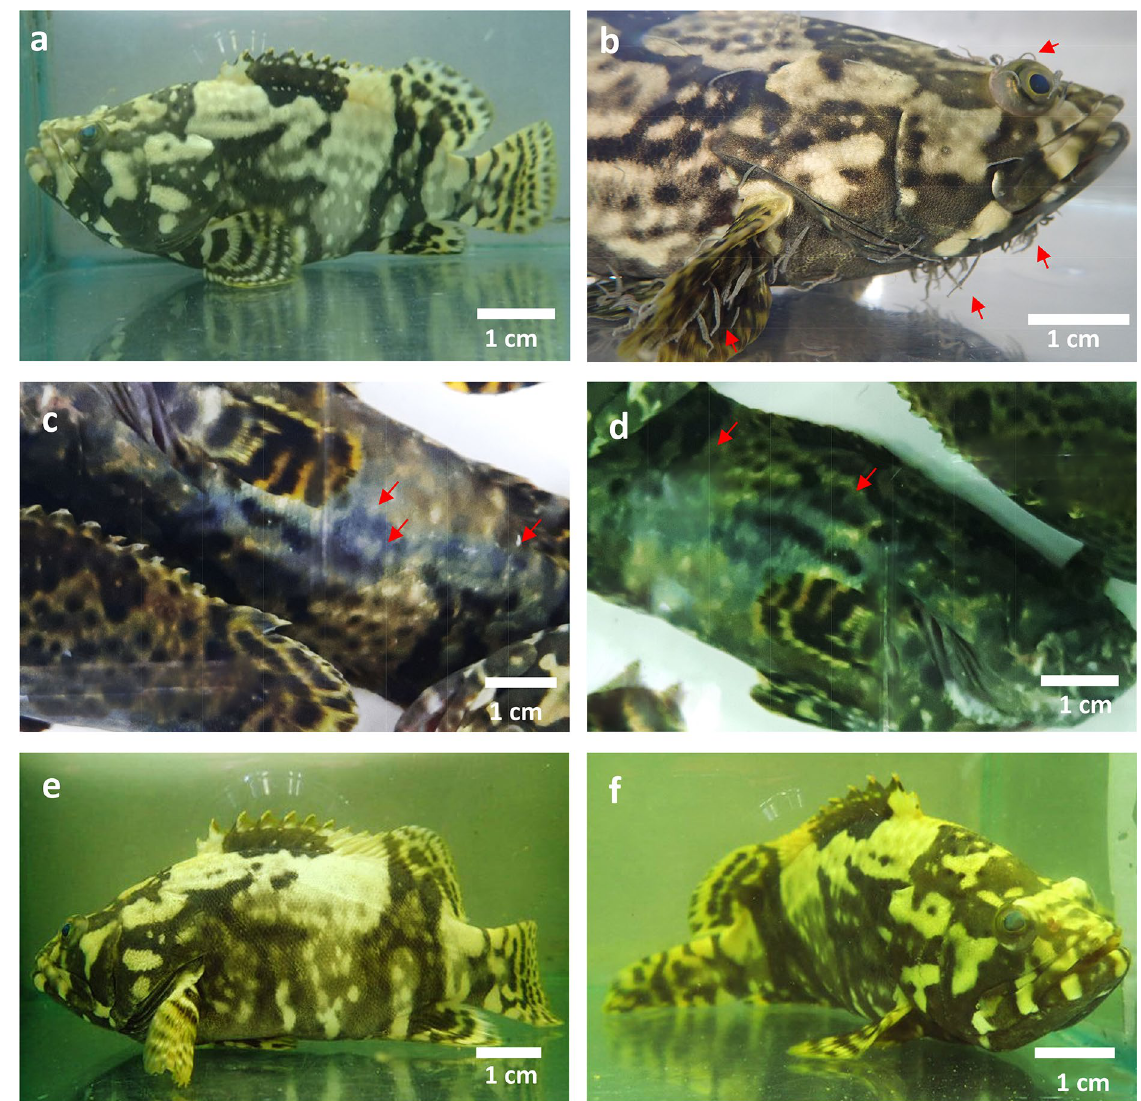
Figure 2. Hybrid groupers ( Epinephelus fuscoguttatus x E.lanceolatus ) ( a ) normal control, ( b ) positive control, highly infested with parasitic leeches, the arrow indicates the prevalence of the leeches on the head, eyes and fins area, ( c,d ) formalin (0.1%) treated group, arrows indicate the appearance of wounds on the body surface due to the aggressive swimming and stress induced by the chemical, ( e,f ) Nephrolepis biserrata methanol extract administered group, no wounds or leeches were noticed on the surface of the fishes after the treatment.